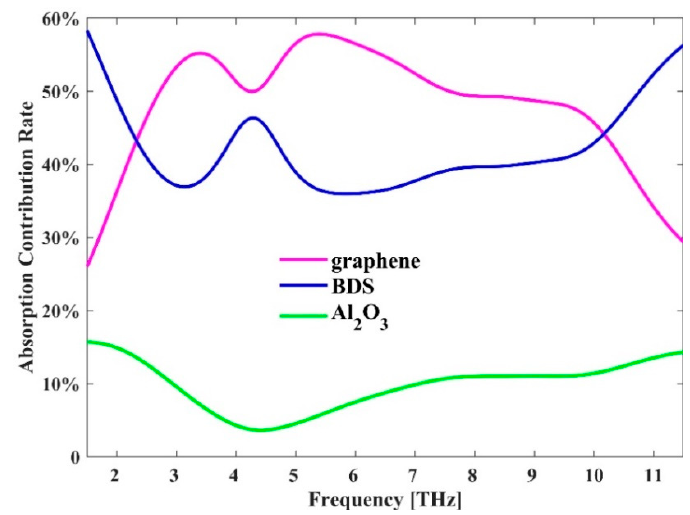
Figure 9. The absorption contribution rate of graphene, BDS and Al 2 O 3 in the proposed hybrid absorber.